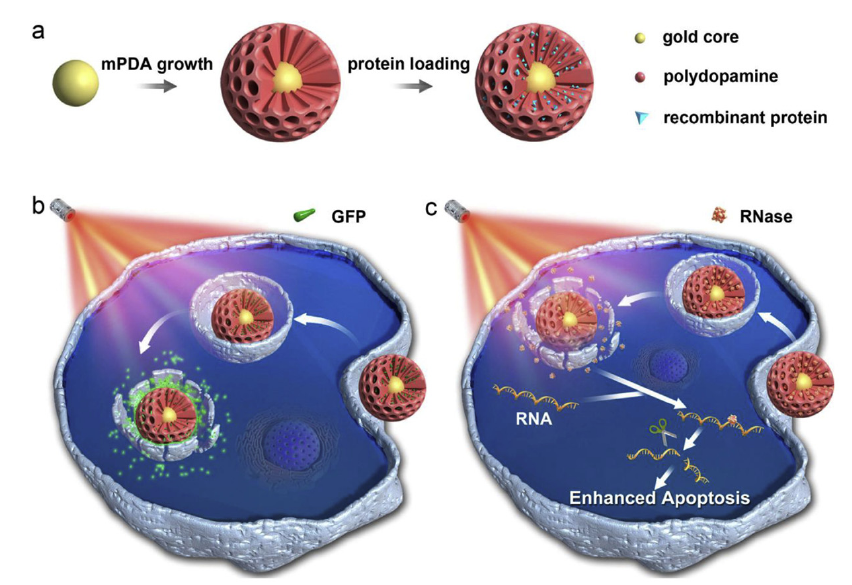
Figure 10. A schematic representation of ( a ) protein loading into mPDA matrix, ( b ) release of GFP protein based on NIR, and ( c ) release of RNase based on NIR [92]. Reprinted from Biomaterials, 238, D. Wu et al., Mesoporous Polydopamine with Built-in Plasmonic Core: Traceable and NIR Triggered Delivery of Functional Proteins, 119847, Copyright (2020), with permission from